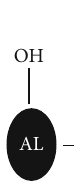
Figure 1: Chemical construction of ATH